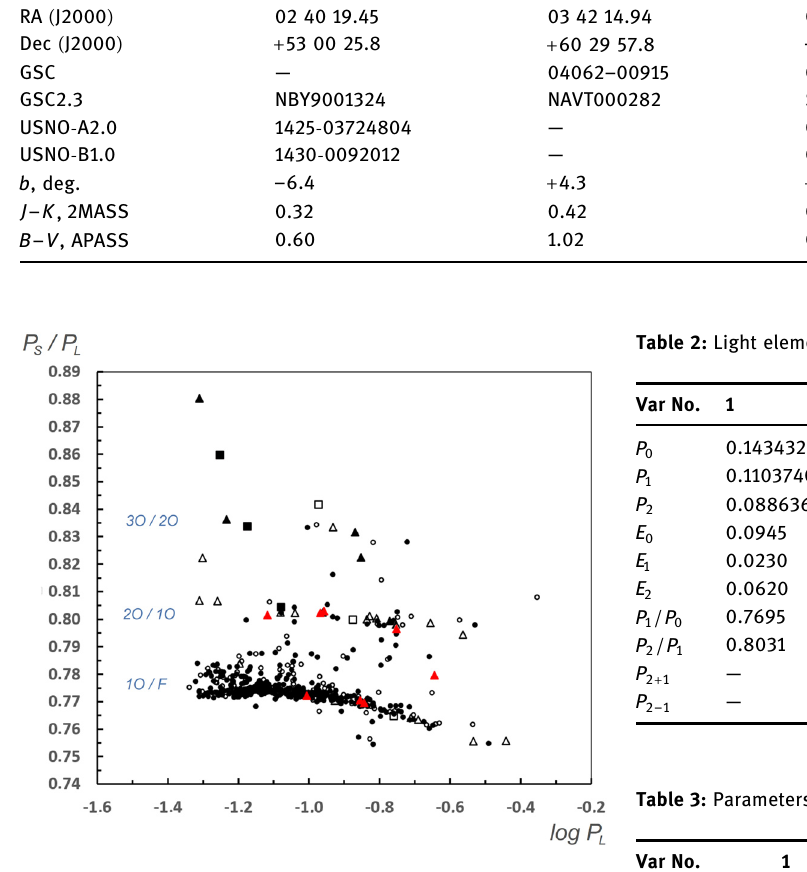
Figure 5: The Petersen diagram for HADS ( B ) stars.